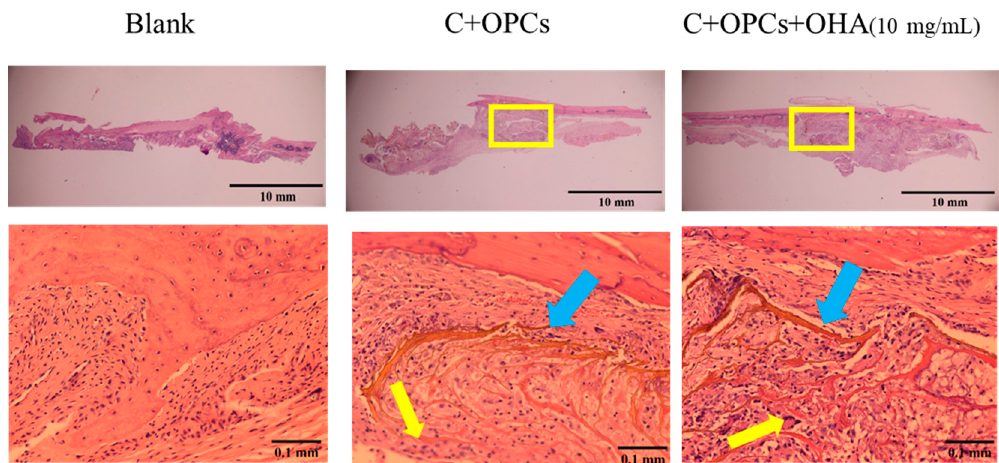
Figure 13. Histological images of control (Blank), collagen + OPC, and collagen + OPC + OHA scaffolds implanted on a skull defect captured after 4 weeks (upper panel). Enlarged images of areas within the yellow squares in the upper panels are shown in the lower panels (yellow arrows indicate the formation of new blood vessels, and the blue arrows indicate the scaffolds).